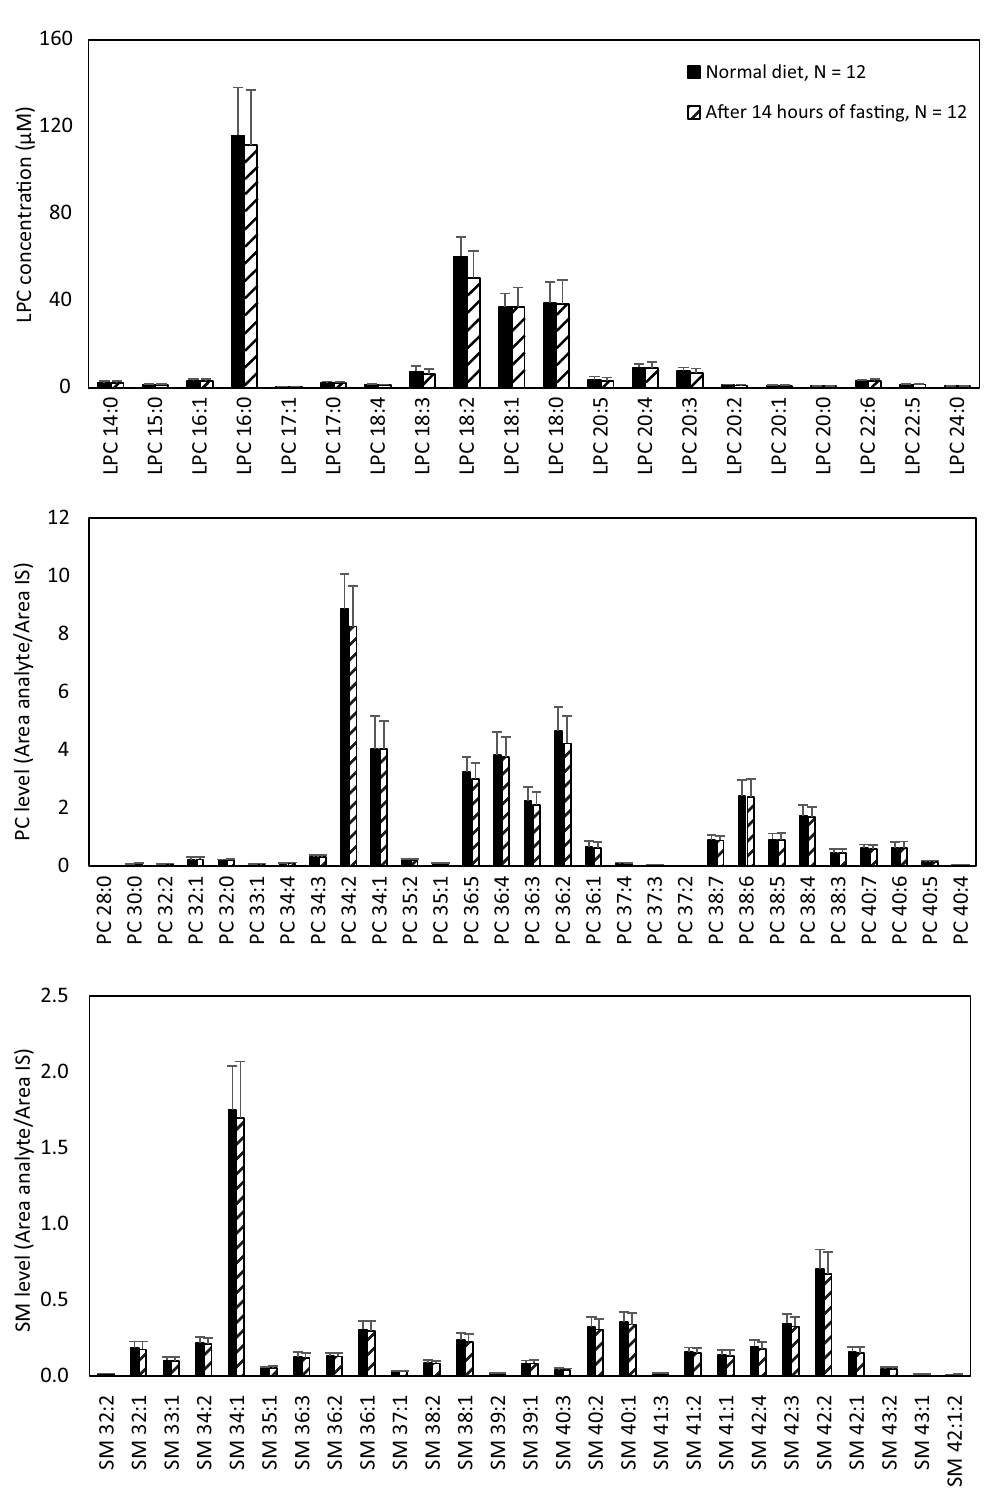
Fig 8. Mean levels of phospholipid species in the sera of 12 healthy subjects before and after 14 hours of fasting. The LPC species were absolutely quantified whereas PCs and SMs were relatively measured in reference to the IS LPC 19:0. Abbreviations: LPC, lysophosphatidylcholine; IS, internal standard; PC, phosphatidylcholine; SM,